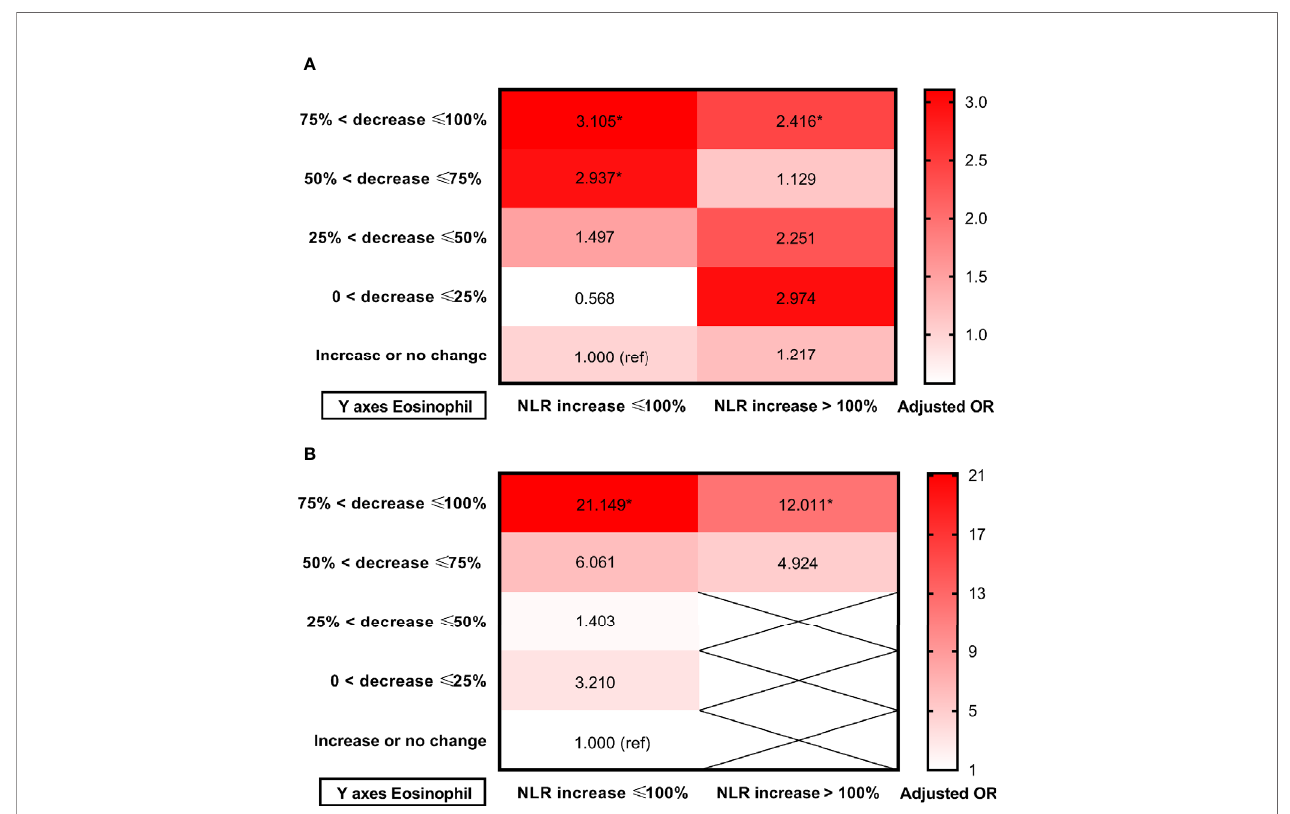
FIGURE 5 | Heat maps of adjusted odds ratios for (A) Poor outcome; (B) Death in the 10 groups established using eosinophil and NLR changes after intravenous thrombolysis. Data were adjusted for age, sex, current smoking, history of hypertension, atrial fi brillation, stroke, triglycerides and admission NIHSS score (model 3). Asterisk indicates p < 0.05. Total patients and outcome events in each group could be found in the Supplementary Figure 2 .